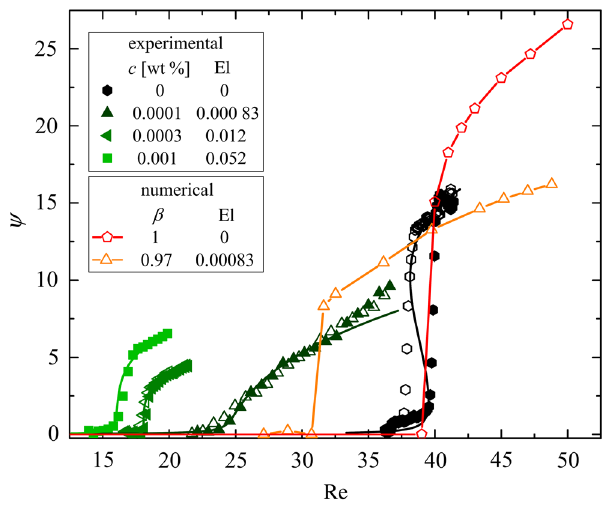
FIG. 9. Order parameter ψ as a function of Re for solutions of PEO in 8 wt % PEG, with the viscosity ratio spanning 0 . 91 < β < 1 for the experimental fluids. Closed symbols indicate data obtained with increasing flow rates and open symbols indicate data obtained with decreasing flow rates. Data are fitted with the Landau model [Eq. (8), solid lines]. Numerical data (decreasing Re ramp only) are obtained with the FENE-MCR model with L 2 ¼ 5000 and